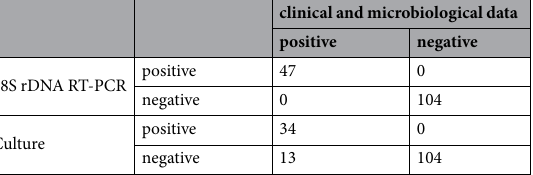
Table 3. Comparison of fungal identification by 18S rDNA RT-PCR and culture (N = 151) applying a gold standard that combines clinical and microbiologal data.